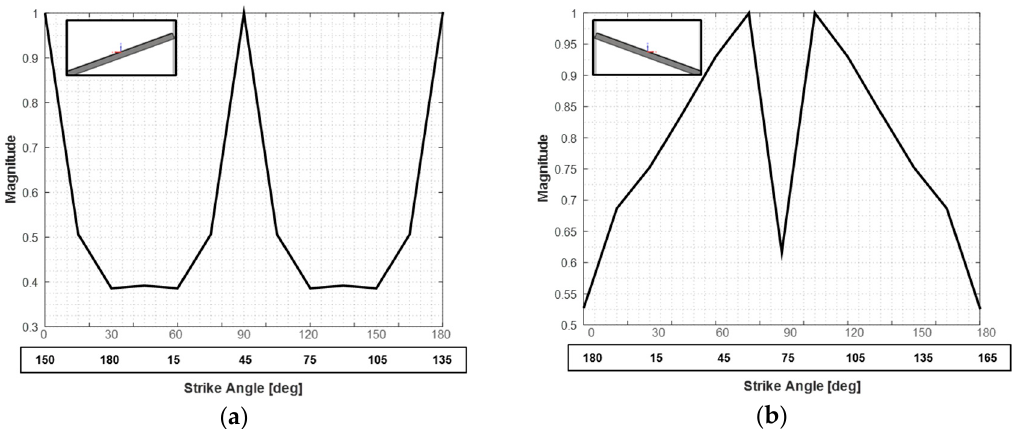
Figure 11. Experimental validation. The bold lower axis represents the correspondence between the theoretical model and the field results: ( a ) Fracture marked A; and ( b ) fracture marked B.